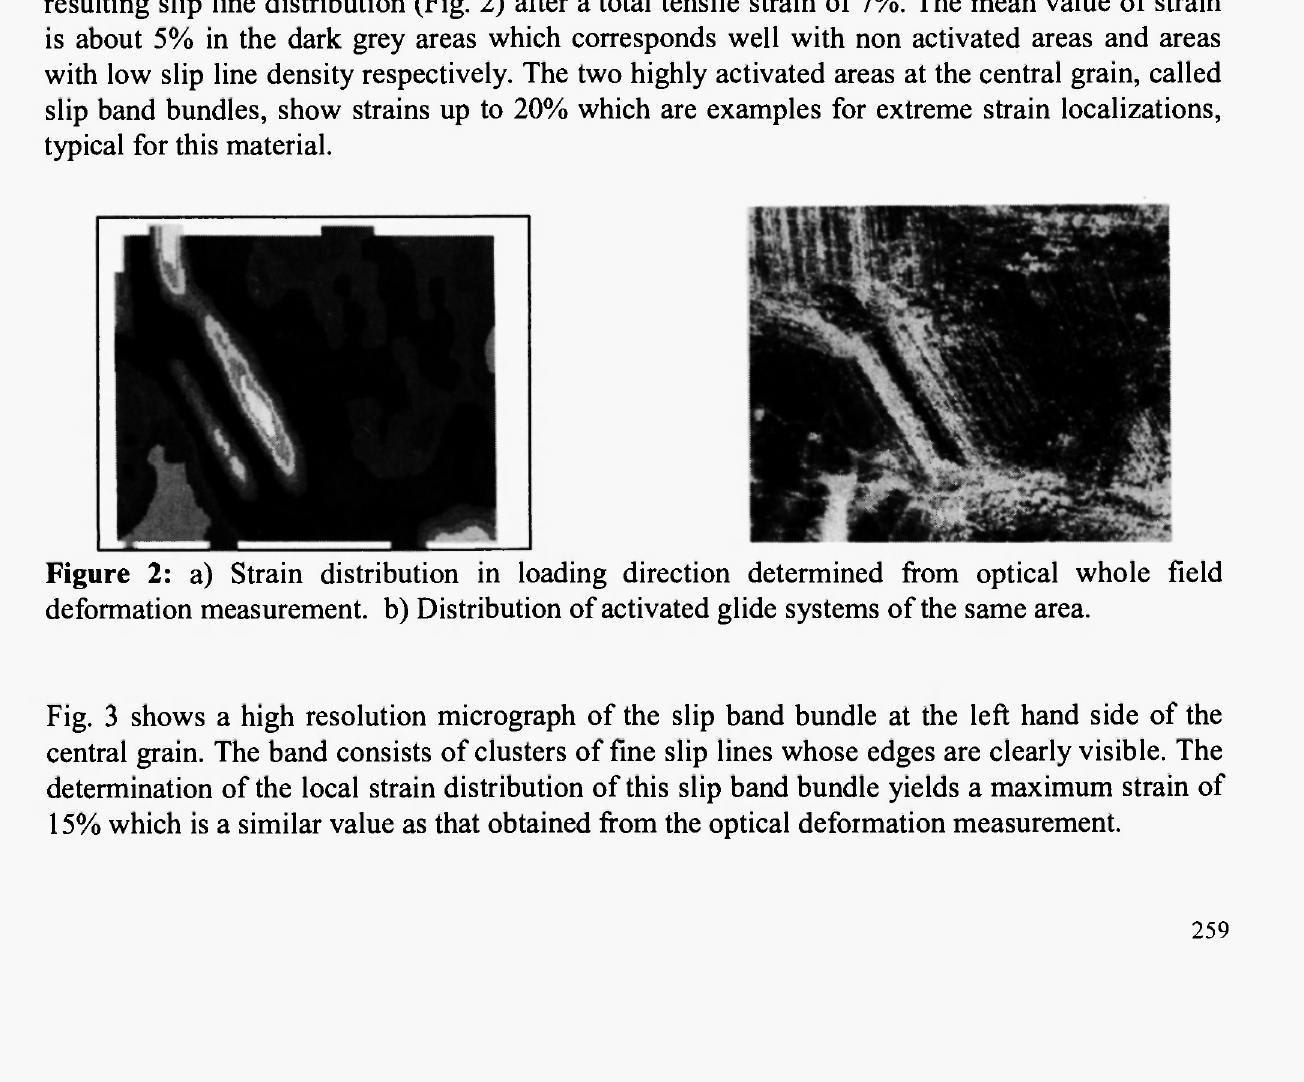
Figure 2: a) Strain distribution in loading direction determined from optical whole field deformation measurement, b) Distribution of activated glide systems of the same